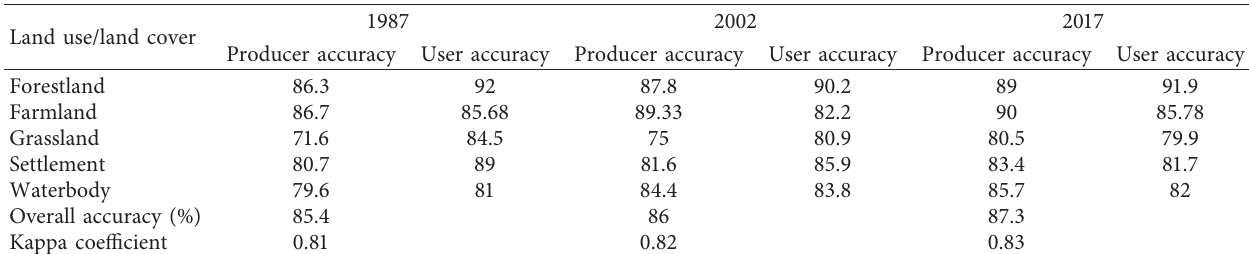
Table 3: Accuracy assessment of 1987, 2002, and 2017 classified